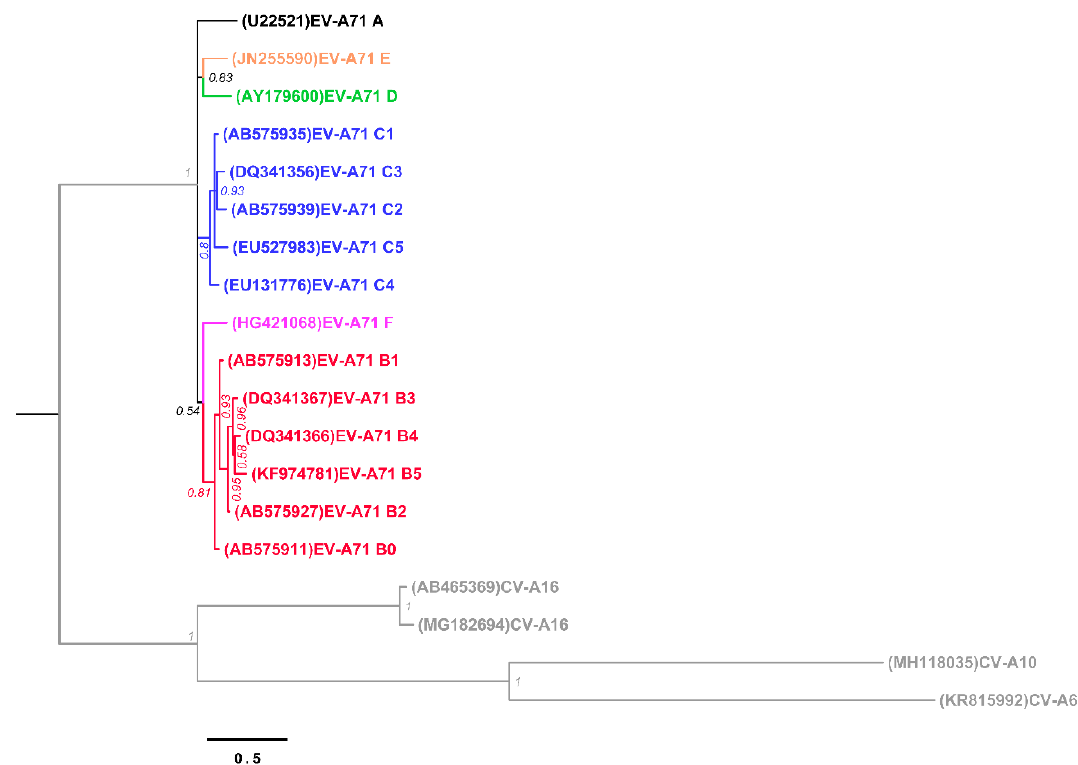
Figure 4. Phylogenetic tree of nucleotide sequences encoding the VP1 in EV-A71 genogroups, CV-A6, CV-A10, and CV-A16. The phylogenetic tree was inferred with MrBayes v3.5 [78] with the general time reversible substitution model allowing for heterogeneity modeled by a gamma distribution and allowing for invariable sites (GTR + G + I) with 5 × 10 6 chain length. The sequences are publicly available in GenBank with the accession number between parentheses. Tips are colored according to the genogroup A, B, C, D, E, F, and CV genotypes (CV-A6, -A10 and -A16), as black, red, blue, green, orange, purple and gray, respectively. Posterior probability supporting the topology is shown next to the branches.